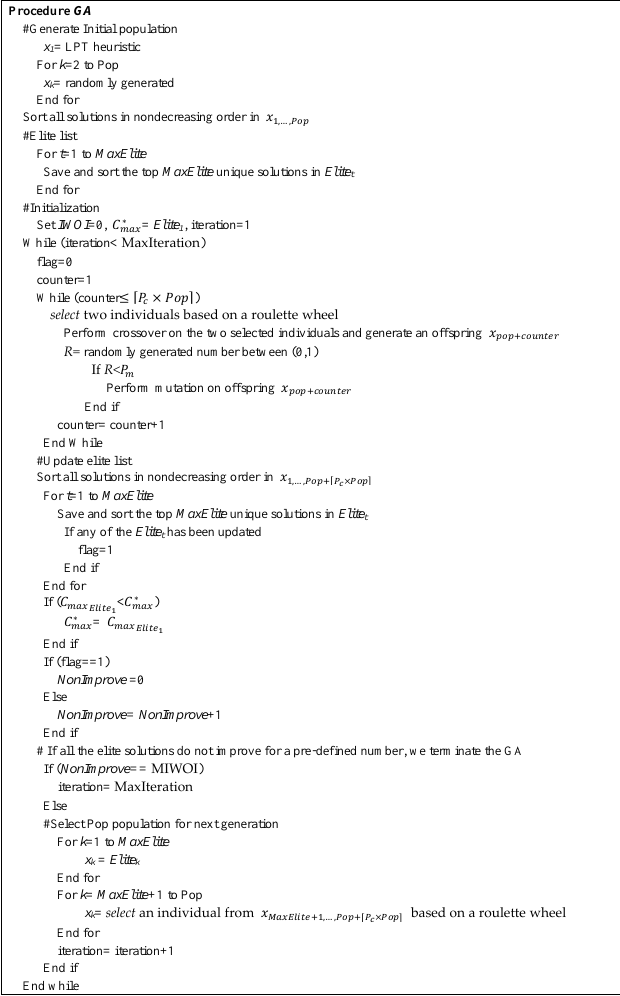
Figure 6. A search procedure for the proposed